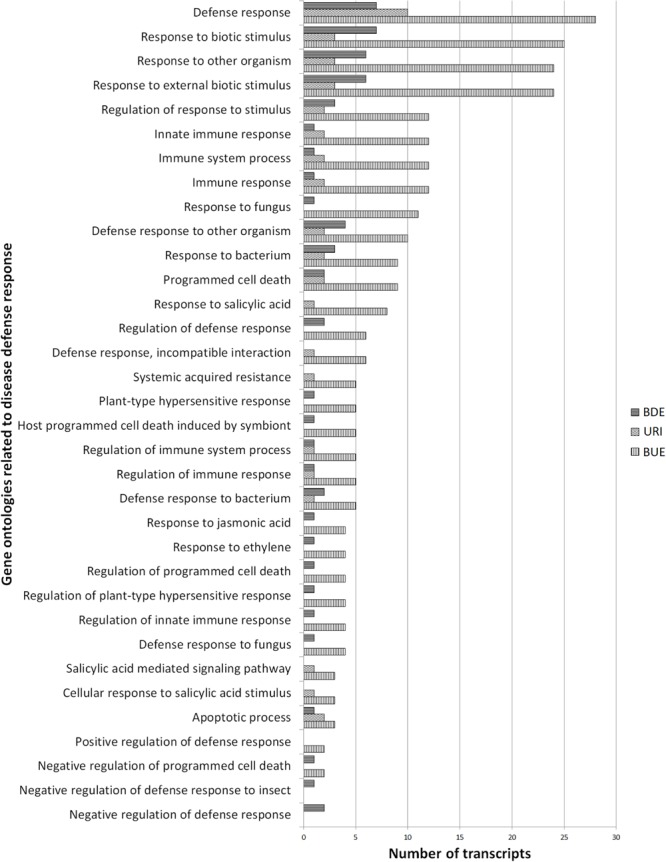
Number of differentially regulated transcripts associated with host defense response. The URI group represents the up-regulated transcripts in inoculated resistant buffalograss lines compared to inoculated susceptible lines. The BUE group refers to the transcripts expressed more in uninoculated resistant lines in comparison to uninoculated susceptible lines. BDE represents the down-regulated transcripts in uninoculated resistant lines compared to uninoculated susceptible lines.